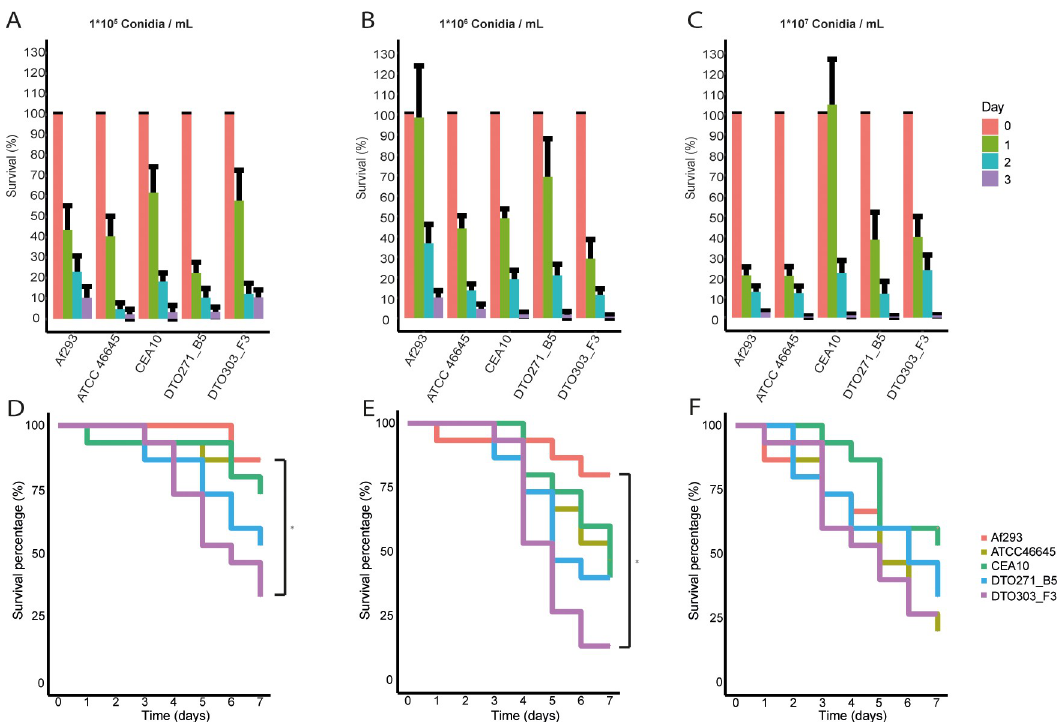
Fig 9. Survival of A . fumigatus (A-C) and G . melonella larvae (D-F) after infection. Bar graph of A . fumigatus survival and Kaplan- Meier survival plots of G . melonella over 3 or 7 days of incubation with 10 5 (A, D), 10 6 (B, E) and 10 7 (C, F) conidia mL -1 , respectively. Bars represent the average ( ± SE) of three independent experiments. Each line consists of three biological replicates. � indicates statistical significance, fungal survival is based on a Kruskal Wallis test and the larvae survival on a non-parametric log rank test, both with a p-value � 0.05.